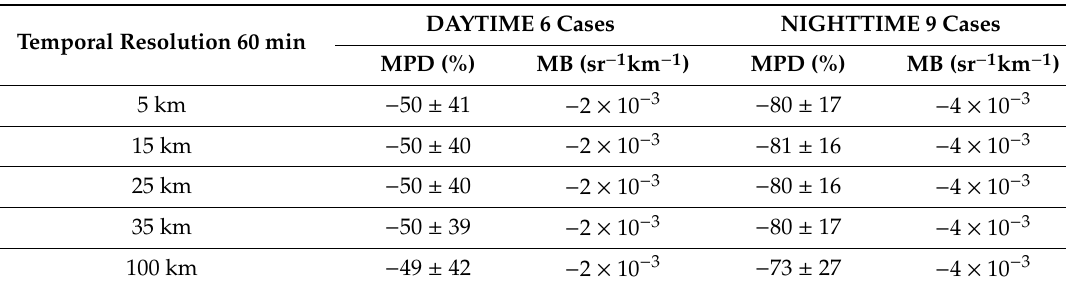
Table 3. Statistical results (MPD, MB) derived from simultaneous measurements between CALIOP and Mace Head data for the 6 daytime and 9 nighttime cases considering di ff erent along–track averages in CALIOP data (5 km, 15 km, 25 km, 35 km, and 100 km).